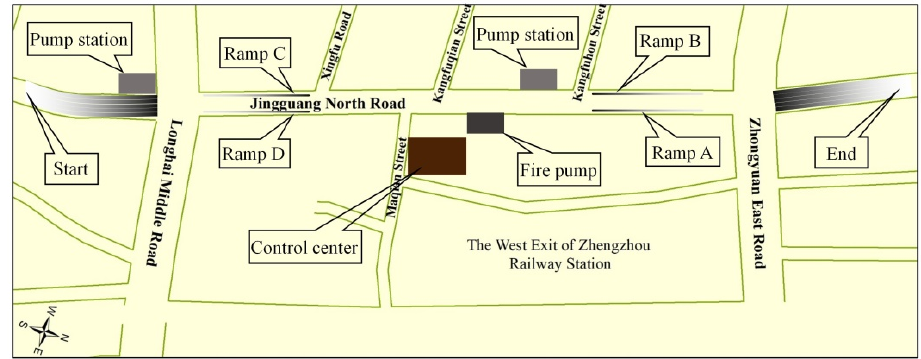
Figure 17. The floor plan of Jingguang North Road Tunnel (redrawn from [31]).